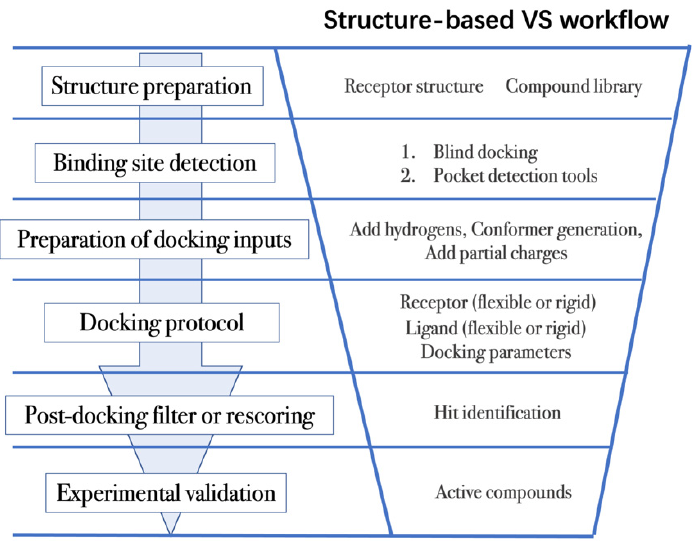
Figure 3. General scheme of a VS workflow.